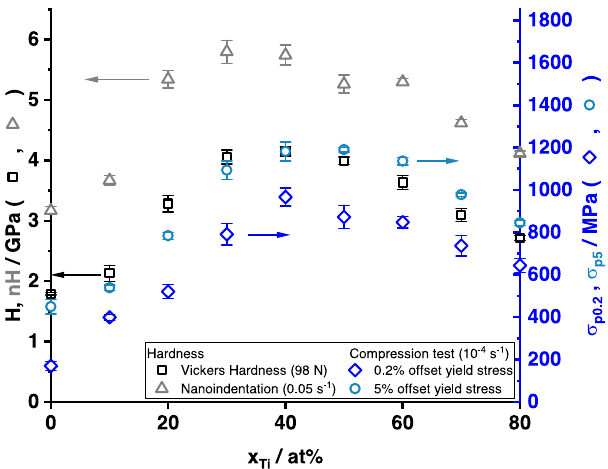
Fig. 3 Mechanical properties of Mo-Ti solid solutions. Vickers hardness H and nanohardness nH (black squares and gray triangles, respectively, left axis) and 0.2% and 5% offset yield strength σ p0.2 and σ p5 (dark blue diamonds and light blue circles, respectively, right axis) as a function of Ti content x Ti for the Mo-Ti